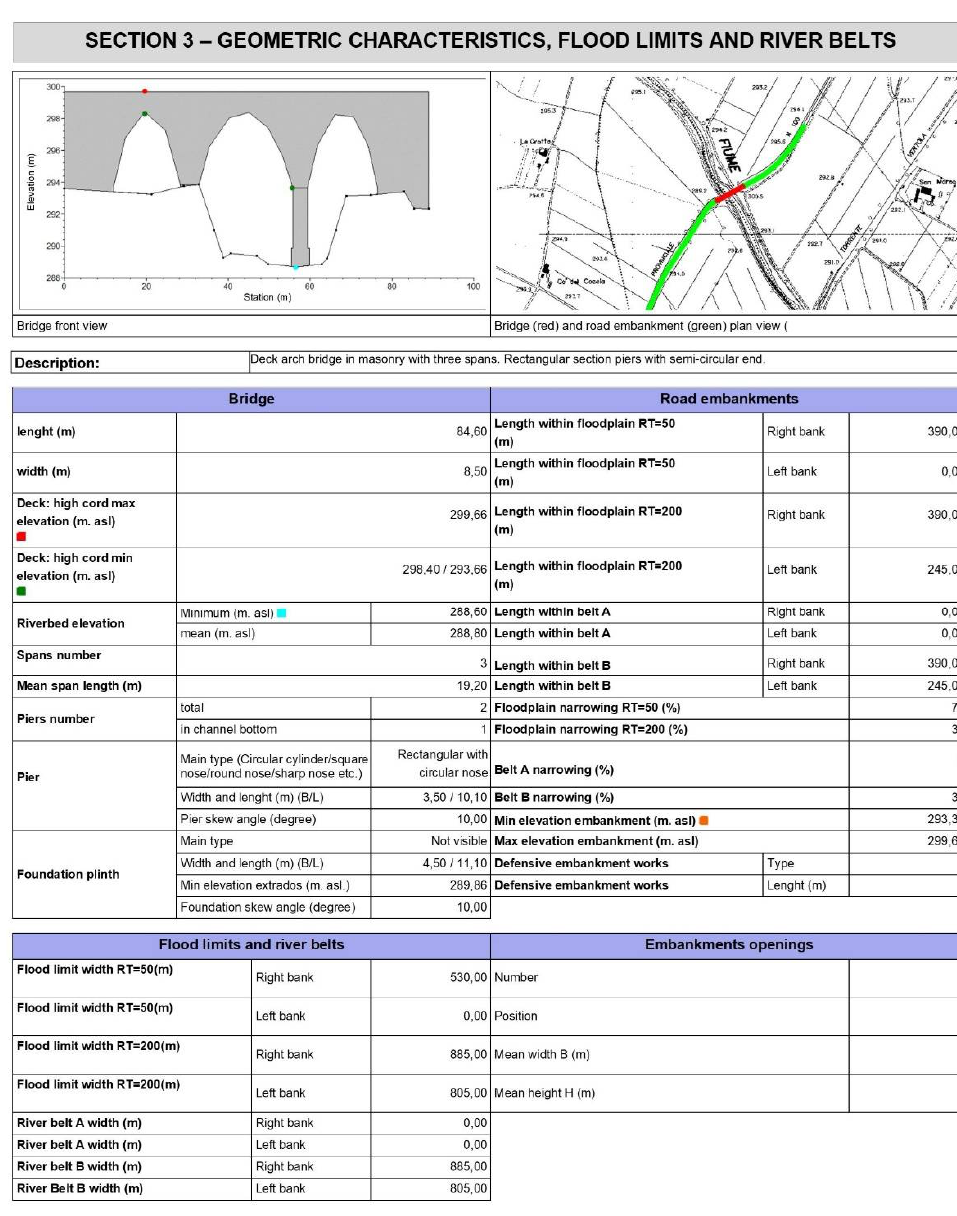
Figure A2. Synoptic table for Section 3.